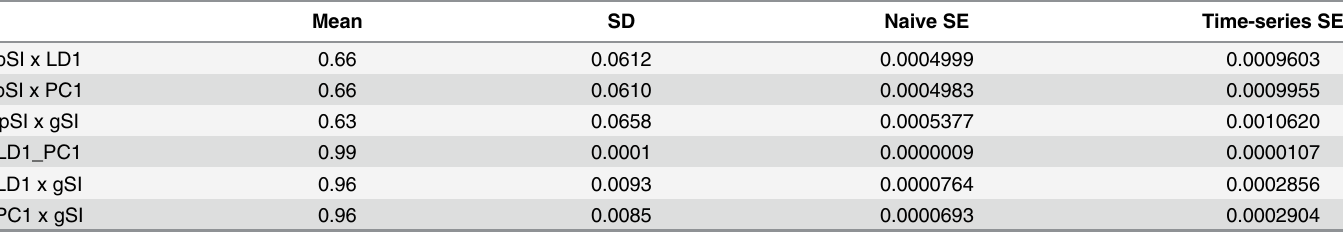
Table 11. Mean, standard deviation (SD), naive standard error (SE) of the mean and time-series standard error (SE) of Spearman correlation among the predicted values from selection index and multivariate